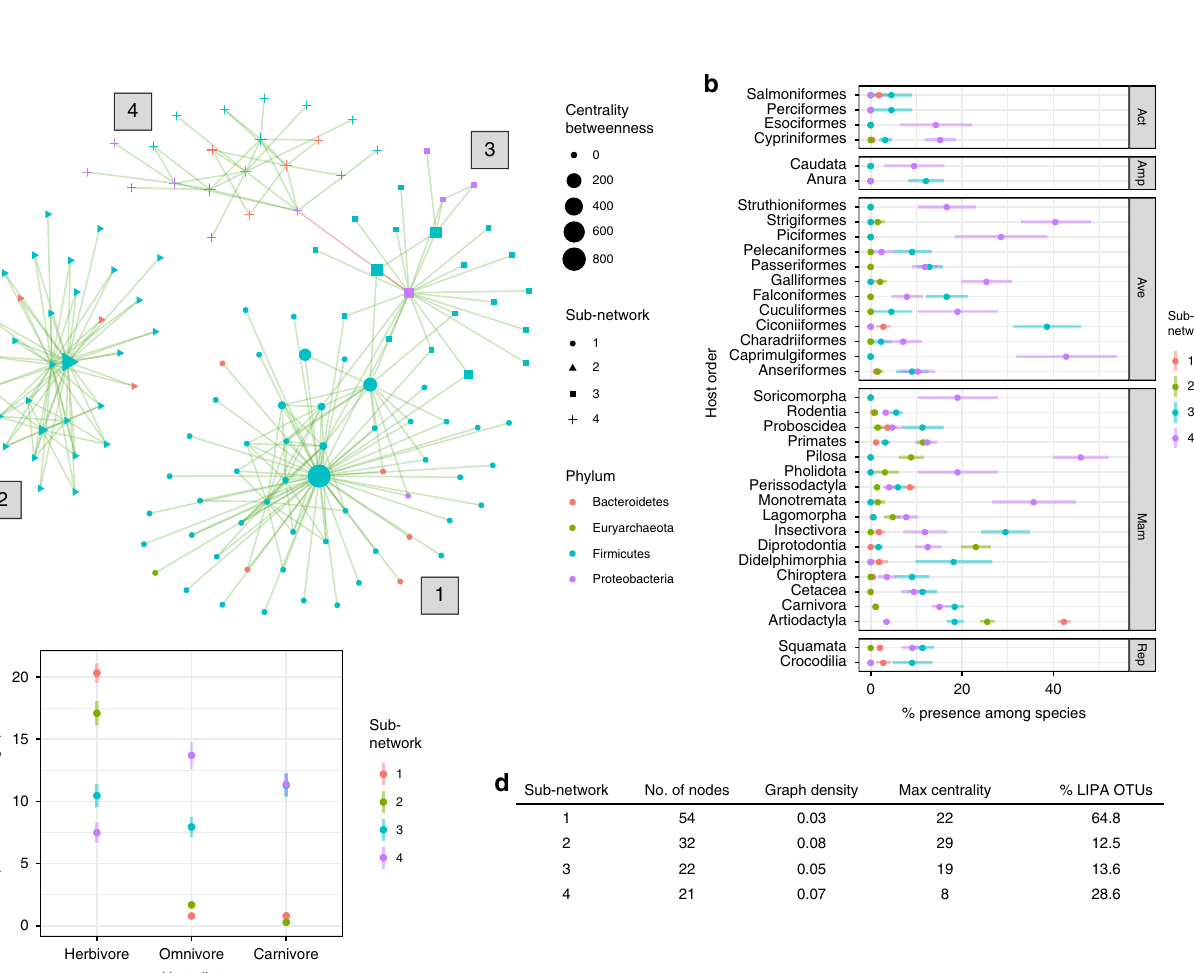
Fig. 6 Microbial communities are generally phylogenetically clustered versus evenly distributed. a The phylogeny is the same as shown in Fig. 1. From inner to outer, the data mapped onto the tree is host diet, mean standardized effect sizes for mean phylogenetic distance (MPD) and mean nearest taxon distance (MNTD), and samples with signi fi cant phylogenetic clustering or evenness based on MPD or MNTD. The animal species possessing microbial communities that were phylogenetically evenly distributed were the long-eared owl ( Asio otus ), fallow deer ( Dama dama ), red deer ( Cervus elaphus ), cattle ( Bos taurus ), and sheep ( Ovis aries ). b The bar charts depict the fraction of host species for each host class/diet where microbial taxa are more phylogenetically clustered (clustered) or evenly distributed (even) than expected from the null model or those that did not deviate from the null